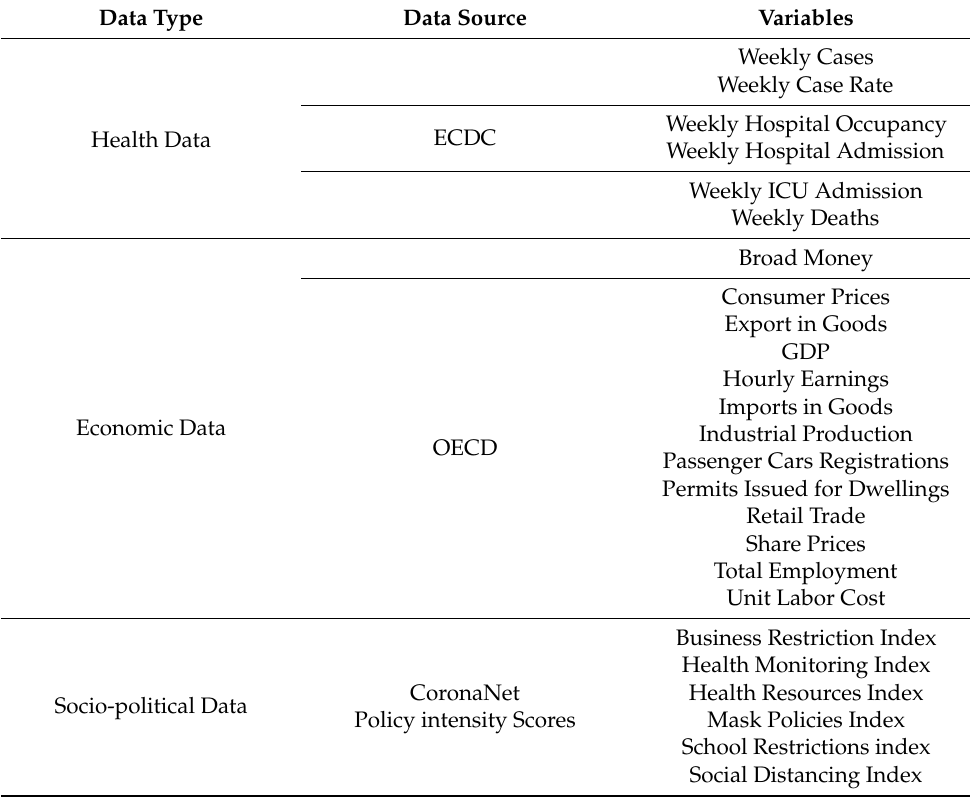
Table 1. Data currently available in the Atlas for visualization and